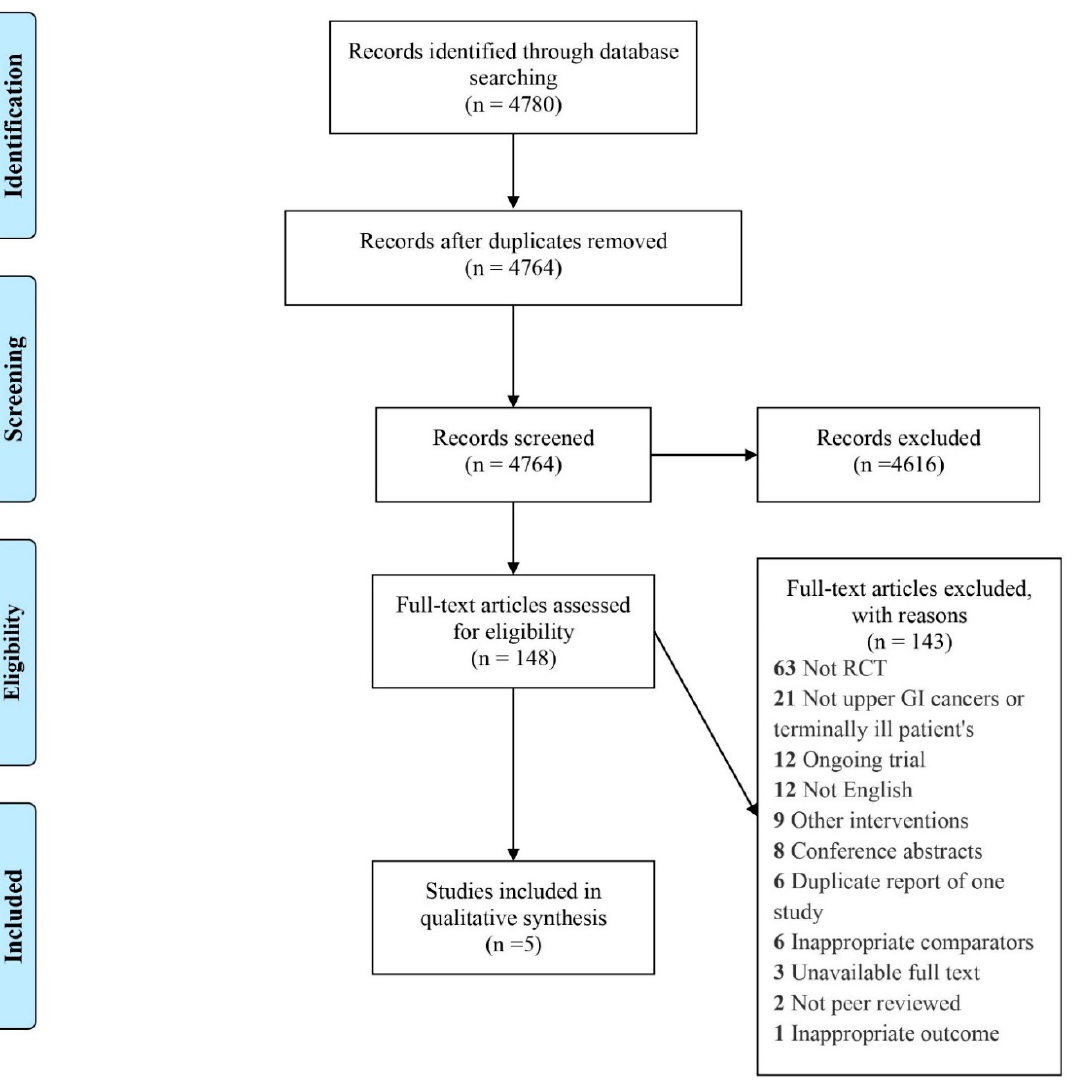
Figure 1. PRISMA flow diagram.